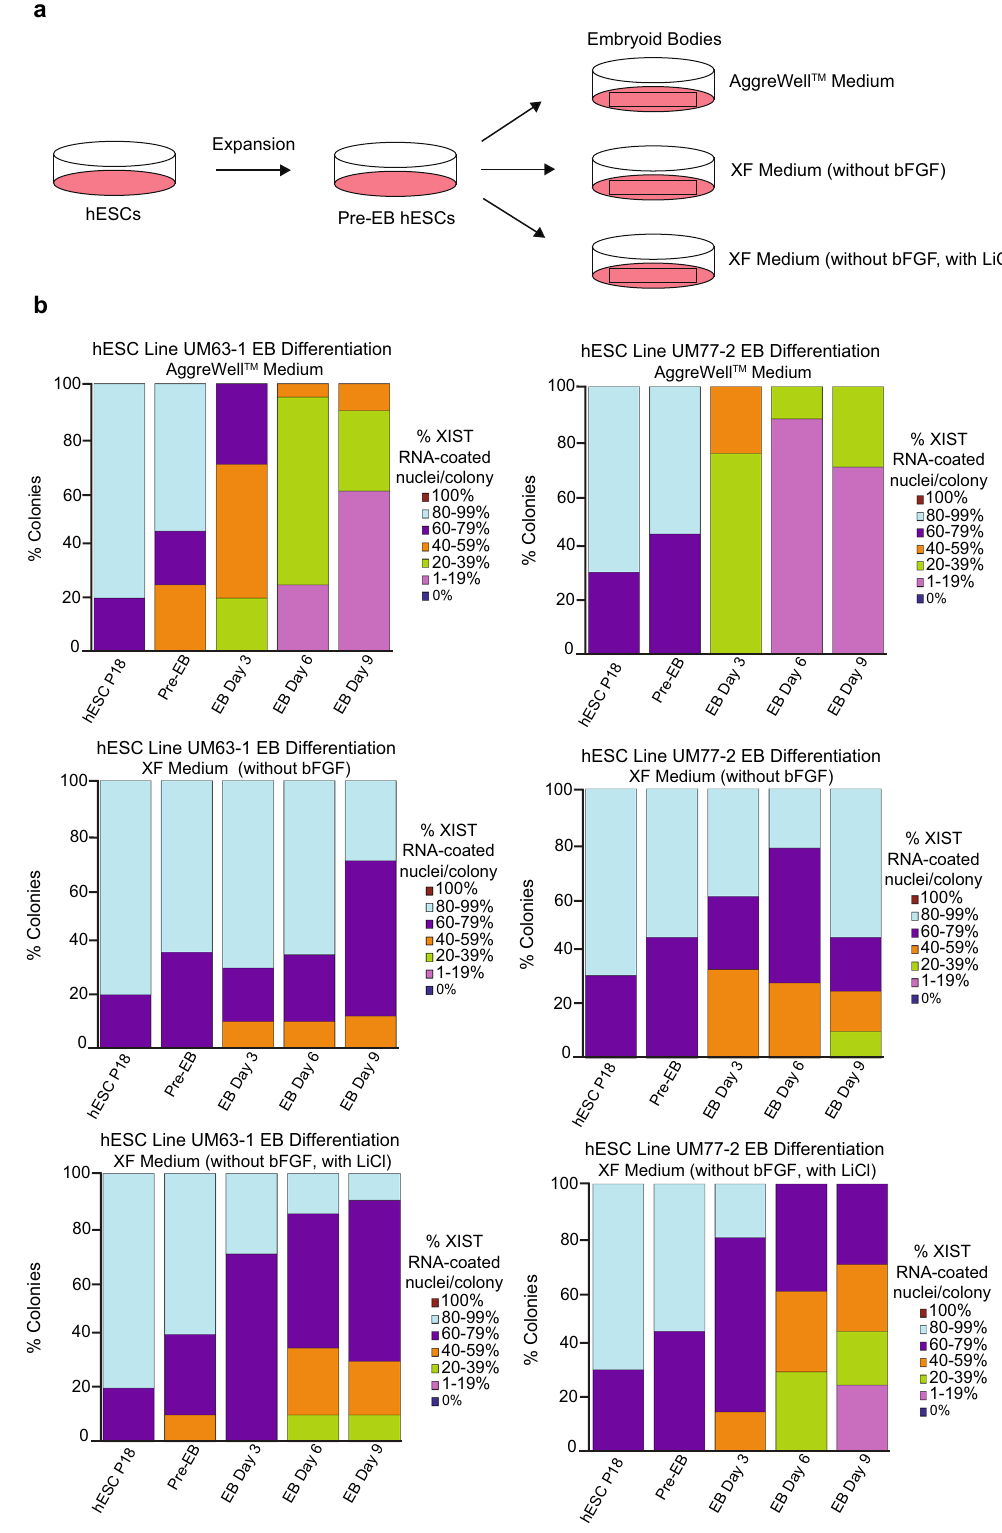
Fig. 7 Analysis of XIST RNA coating during differentiation of female hESCs. a Schematic of hESC differentiation into embryoid bodies (EBs) with three different media formulations: a commercially available AggreWell TM medium; XF medium lacking bFGF; and XF medium lacking bFGF but containing 0.98 mM LiCl. b Percentage of nuclei with XIST RNA coating in EBs generated from hESC lines UM77-2 and UM63-1. EBs generated and cultured in XF medium with LiCl and AggreWell TM medium lost a signi fi cant proportion of XIST RNA coating per colony compared to EBs generated and cultured in XF medium (general linear model comparison; p < 0.001). At least 100 nuclei were counted per colony for hESC RNA FISH quanti fi cation. The total number of colonies quanti fi ed at each passage range between 10 and 17 and are cataloged in source data. Source data are provided as a Source Data fi